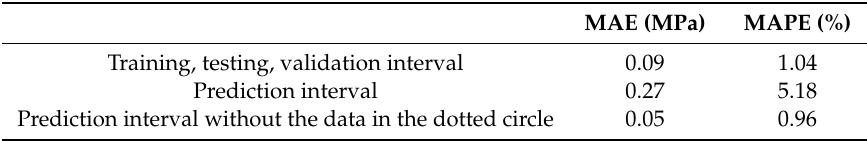
Figure 13. Comparison of predicted and measured THP values. Table 4. Prediction errors in Process 2.